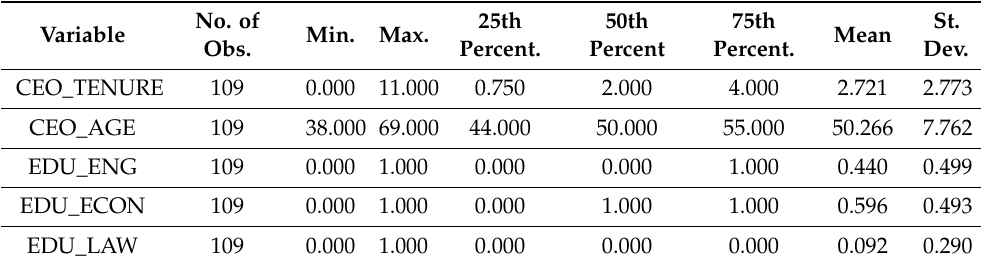
Table 1. Descriptive statistics of the CEO